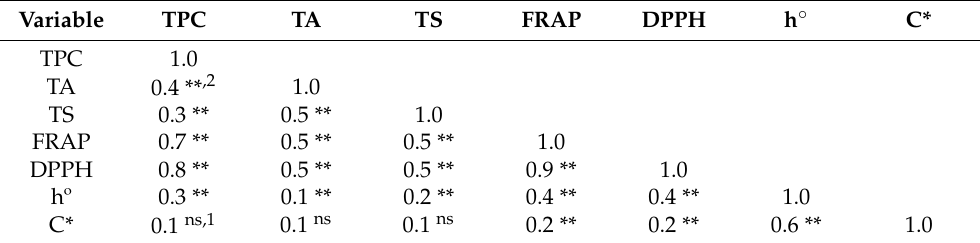
Table 4. Correlation coefficients between bioactive compounds, in vitro antioxidant activity, and physicochemical parameters in green beans from bean